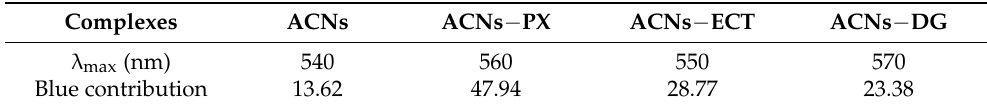
Table 1. The λ max and the calculated blue contribution of the anthocyanin complexes.